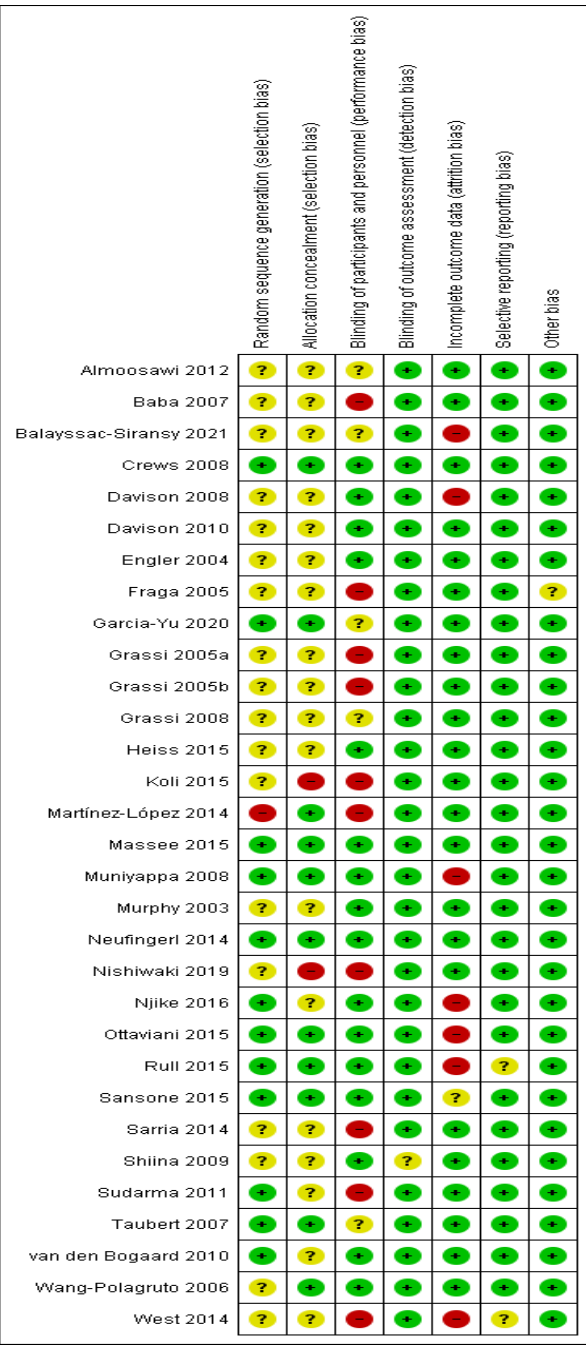
Figure 3. Risk of bias assessment for each study report. Symbols: ?, unclear risk of bias; +, low risk of bias; -, high risk of bias.